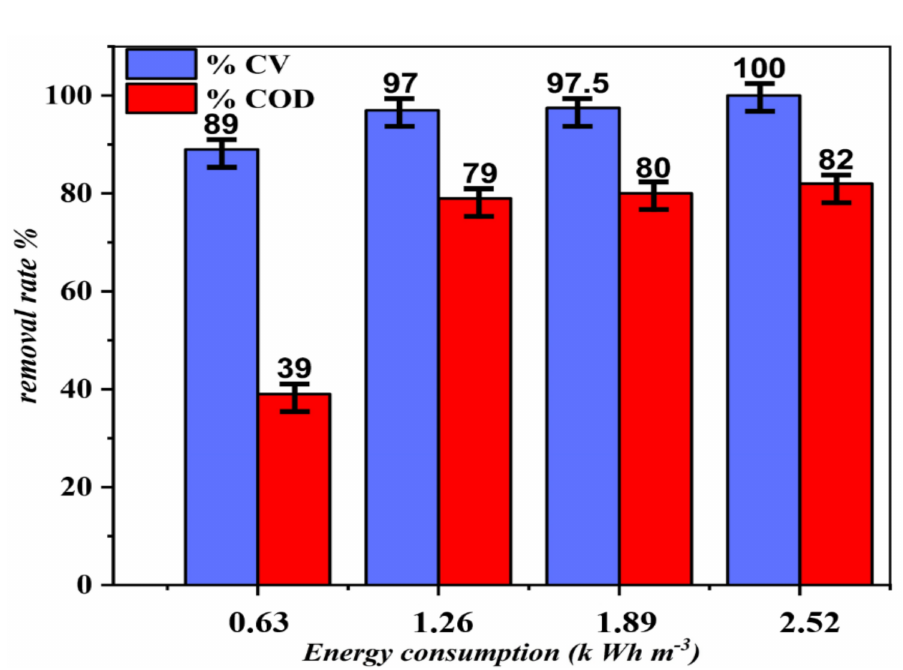
Figure 10. Evolution of decolorization and COD of CV dye as a function of energy consumption ([CV] 0 = 10 mg L − 1 , 50 mA cm − 2 , initial pH = 7, temperature = 25 ◦